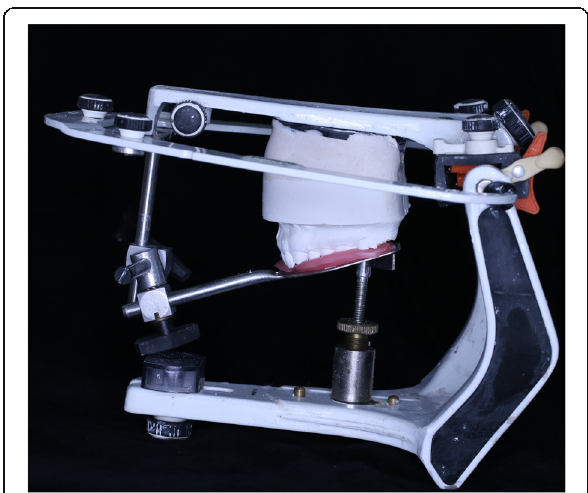
Fig. 2 Transfer of the face-bow record to the semi-adjustable articulator to allow for accurate mandibular cast